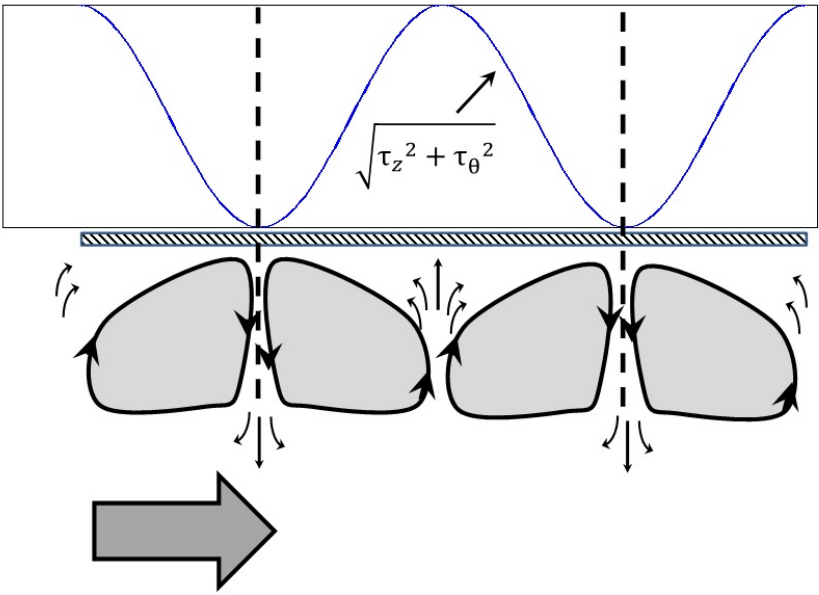
Figure 16. Schematic representation of the counter-rotating vortices at the wall of the Taylor–Couette flow.